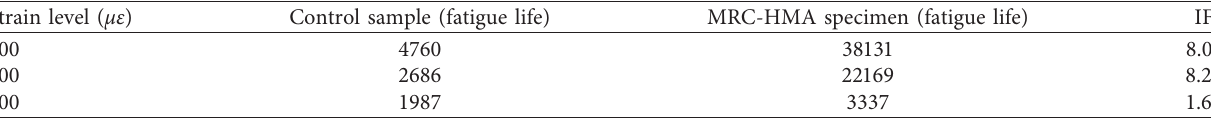
Table 7: Ratio of the number of load repetitions in the MRC-HMA mixture specimens to the control specimen. Strain level ( με )